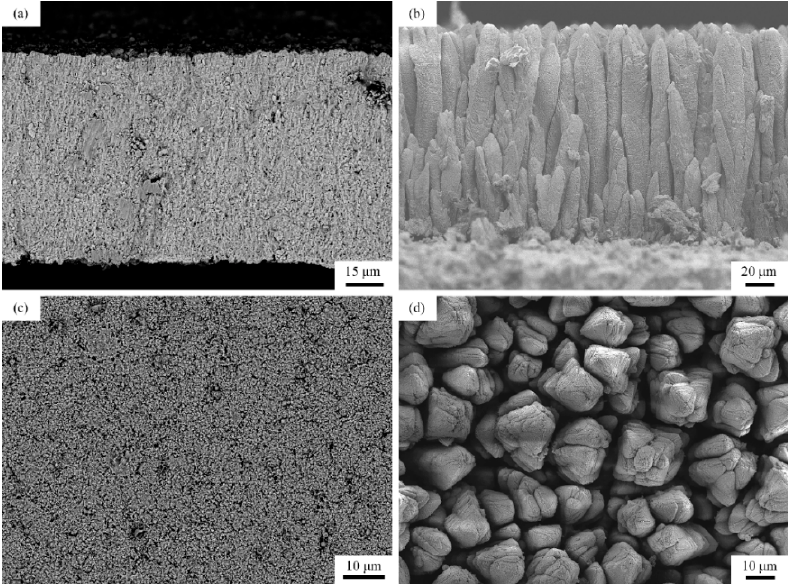
Figure 1. The fracture section ( a , b ) and surface ( c , d ) of the as-sprayed TBCs prepared by PS-PVD: ( a , c ) YSZ-1; ( b , d )